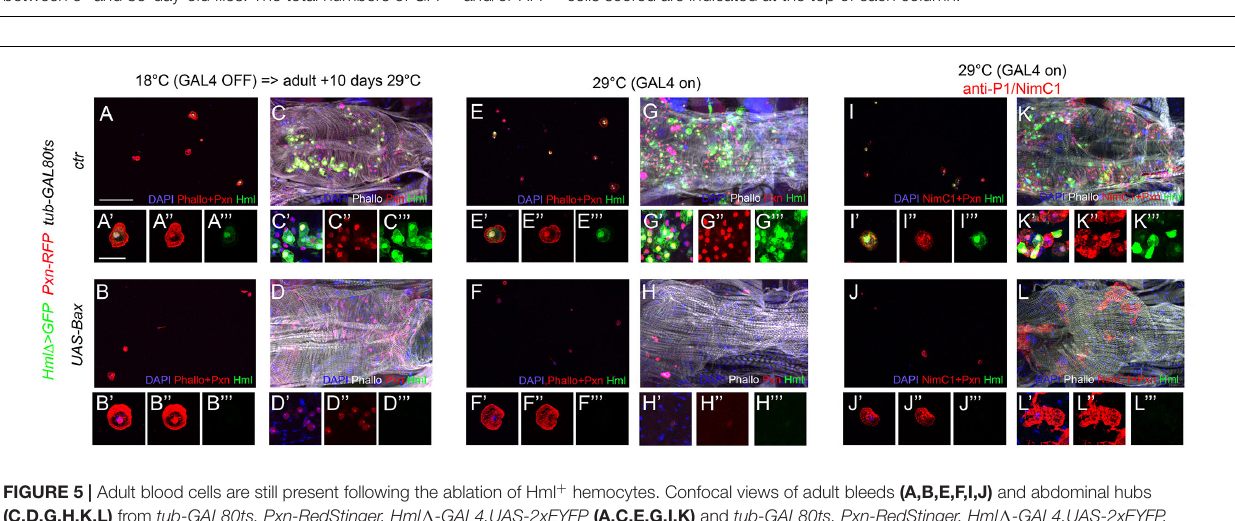
FIGURE 4 | Analysis of blood cell transgenic markers in the adult abdomen. (A–F) Confocal views of the abdominal segments A1 to A4 of 5-day-old females carrying the following transgenes: srpHemo-His2A-RFP (A) , Pxn-RedStinger (B) , Cg25C-GFP (C) , Hml (cid:49) -GAL4,UAS-2xEYFP (D) , crq-GAL4,UAS-2xEYFP (E) , BcF2-GFP (F) , domeMeso-GAL4,UAS-2xEYFP (G) . Cells were counterstained with phalloidin ( A,B : green; C–G : red) and DAPI (blue). Arrows in panel (A) indicate pericardial cells expressing srpHemo . The lower panels show only the transgene expression. Scale bar 200 µ m. (H–O) High magnification views of hemocytes in the abdominal hematopoietic hubs (heart region in A1 or A2 segments) of 5-day-old females carrying the following transgenes: srpHemo-His2A-RFP, Hml (cid:49) -GAL4,UAS-2xEYFP (H) , srpHemo-His2A-RFP, BcF2-GFP (I) , srpHemo-His2A-RFP, domeMeso-GAL4,UAS-2xEYFP (J) , Pxn-RedStinger, Hml (cid:49) -GAL4,UAS-2xEYFP (K) , Pxn-RedStinger, domeMeso-GAL4,UAS-2xEYFP (L) , Hml (cid:49) -GAL4,UAS-2xEYFP, BcF6-mCherry (M) , Hml (cid:49) -GAL4,UAS-2xEYFP, crq-RedStinger (N) , Cg25C-GFP, BcF6-mCherry (O) . The lower panels show only the red (H’–O’) or the green (H”–O”) channel. Nuclei were stained with DAPI (blue). Scale bar 50 µ m. (P) Quantifications of the proportion of cells expressing the indicated combination of markers in 5- or 35-day-old flies. Mean values from at least three independent experiments are presented. No significant difference (Student’s t -test p < 0.05) was observed in the proportion of GFP + RFP + , GFP + RFP − or GFP − RFP + blood cell populations between 5- and 35-day-old flies. The total numbers of GFP + and/or RFP + cells scored are indicated at the top of each column.